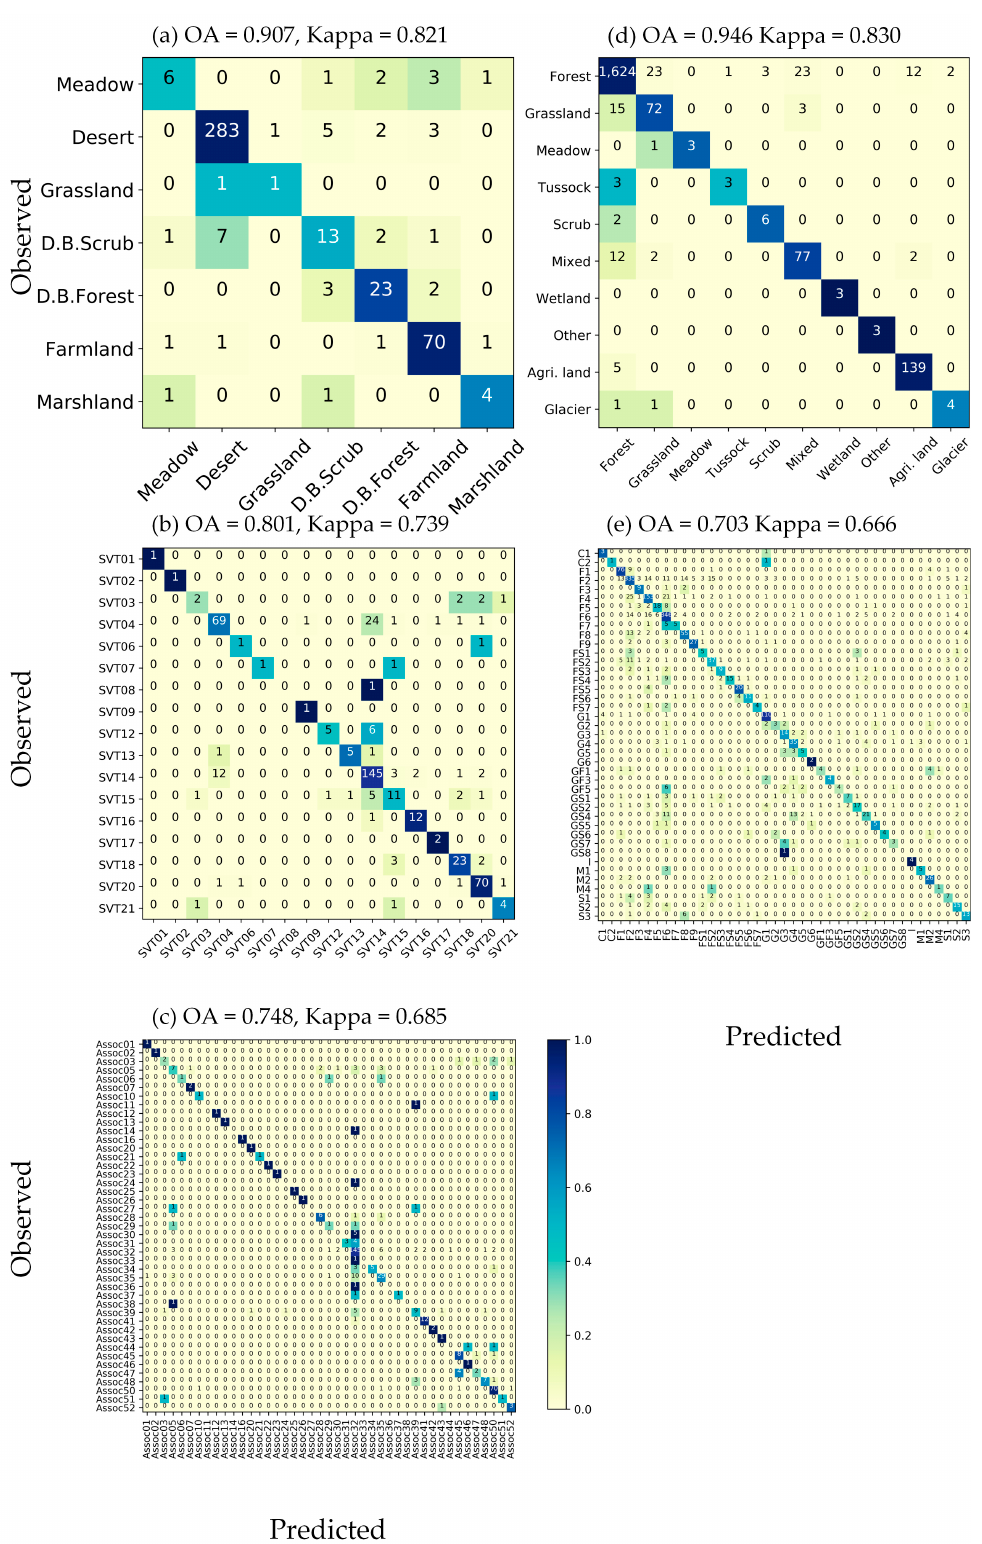
Figure A2. Confusion matrices of ( a ) vegetation types (DzB), ( b ) vegetation subtypes (DzB), References ( c ) associations (DzB), ( d ) habitats (NZ), and ( e ) vegetation classes (NZ) based on the test sets. The meanings of vegetation class abbreviations were explained in Table S1 (DzB) and S2 (NZ) in Supplementary